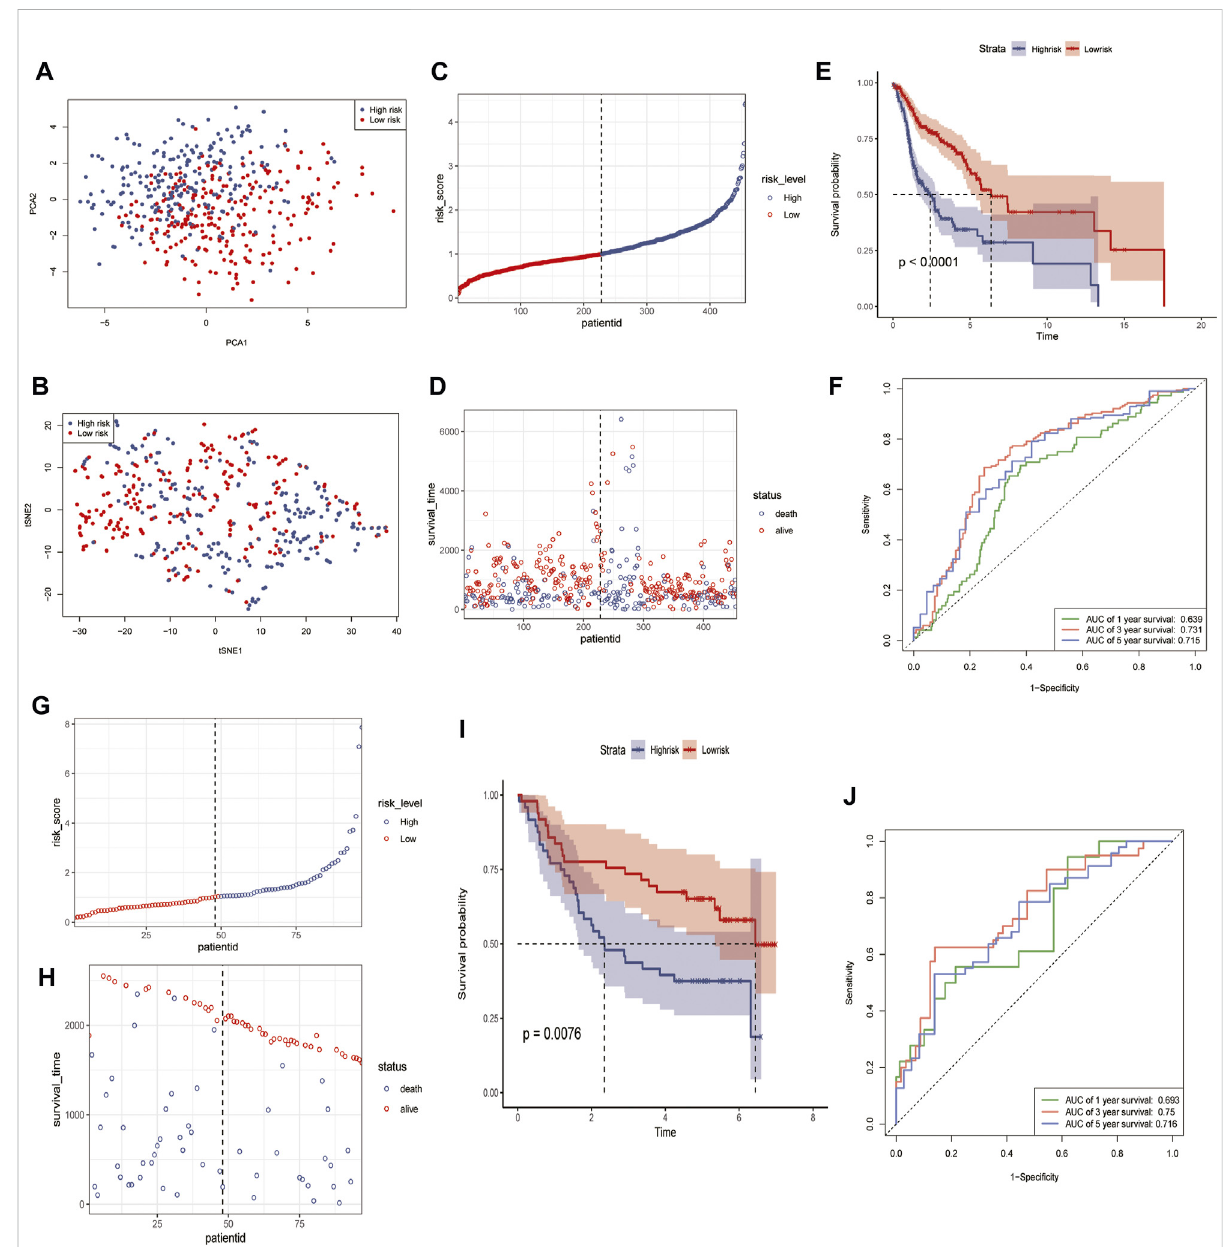
FIGURE 5 Identi fi cation and validation of 13 risk marker genes for prognosis in the TCGA cohort and GSE41613 using R software. (A) PCA in the TCGA cohort. (B) tSNE analysis of the TCGA cohort. (C,G) Risk score distribution in TCGA cohort (C) and GSE41613 (G) . (D,H) Distribution of survival time and survival status in TCGA cohort (D) and GSE41613 (H) . (E,I) Kaplan-Meier curves for the probability of overall survival in the risk group in TCGA (E) and GSE30219 (I) . (F,J) AUC curves for the three groups in TCGA (F) and GSE41613 (J)